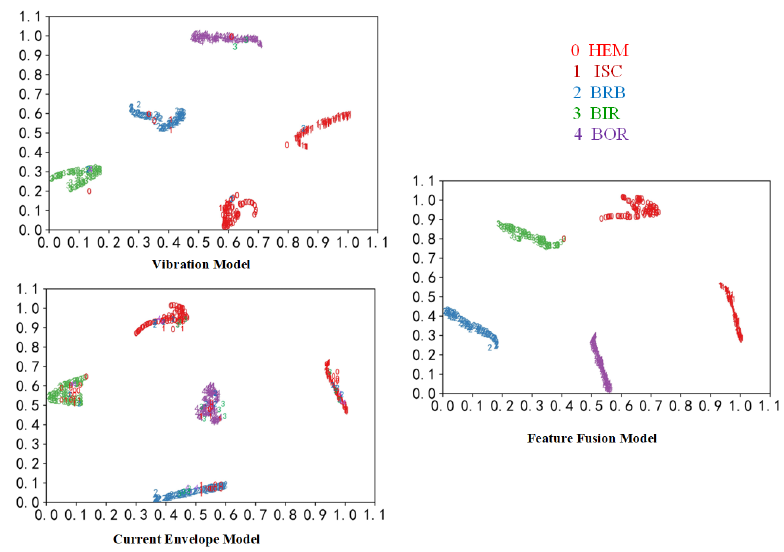
Figure 14. Diagram for t-SNE visualization of each